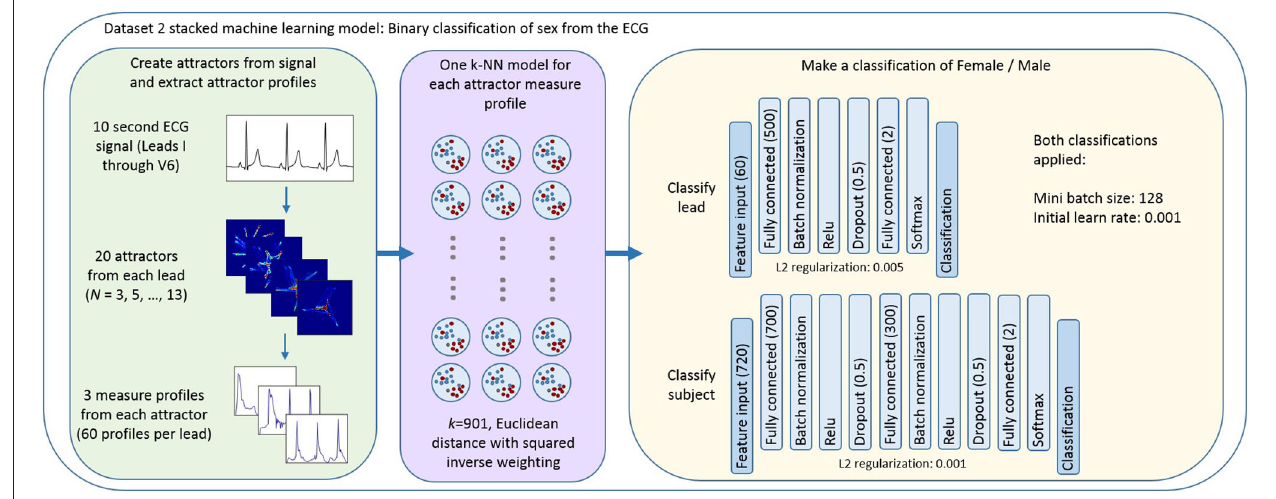
FIGURE 3 | Overview of the stacked machine learning model. Each 10 second ECG lead was used to generate 20 N-point attractors ( N = 3, 5, …, 13), each of which is quantified by three measure set profiles. A k-NN algorithm provides a classification of sex for each measure set (r density, θ density, attractor outline r) for each attractor. The posterior probability scores of each of these classifications formed the feature input to a neural network classifier which provided a classification of sex at (i) a lead level; and (ii) a subject level using data from all the 12 leads. Figure 4 provides the ranges of parameters considered when optimizing the model and further detail of the decisions made in defining the machine learning process and the cross validation approach is provided in the Supplementary Materials